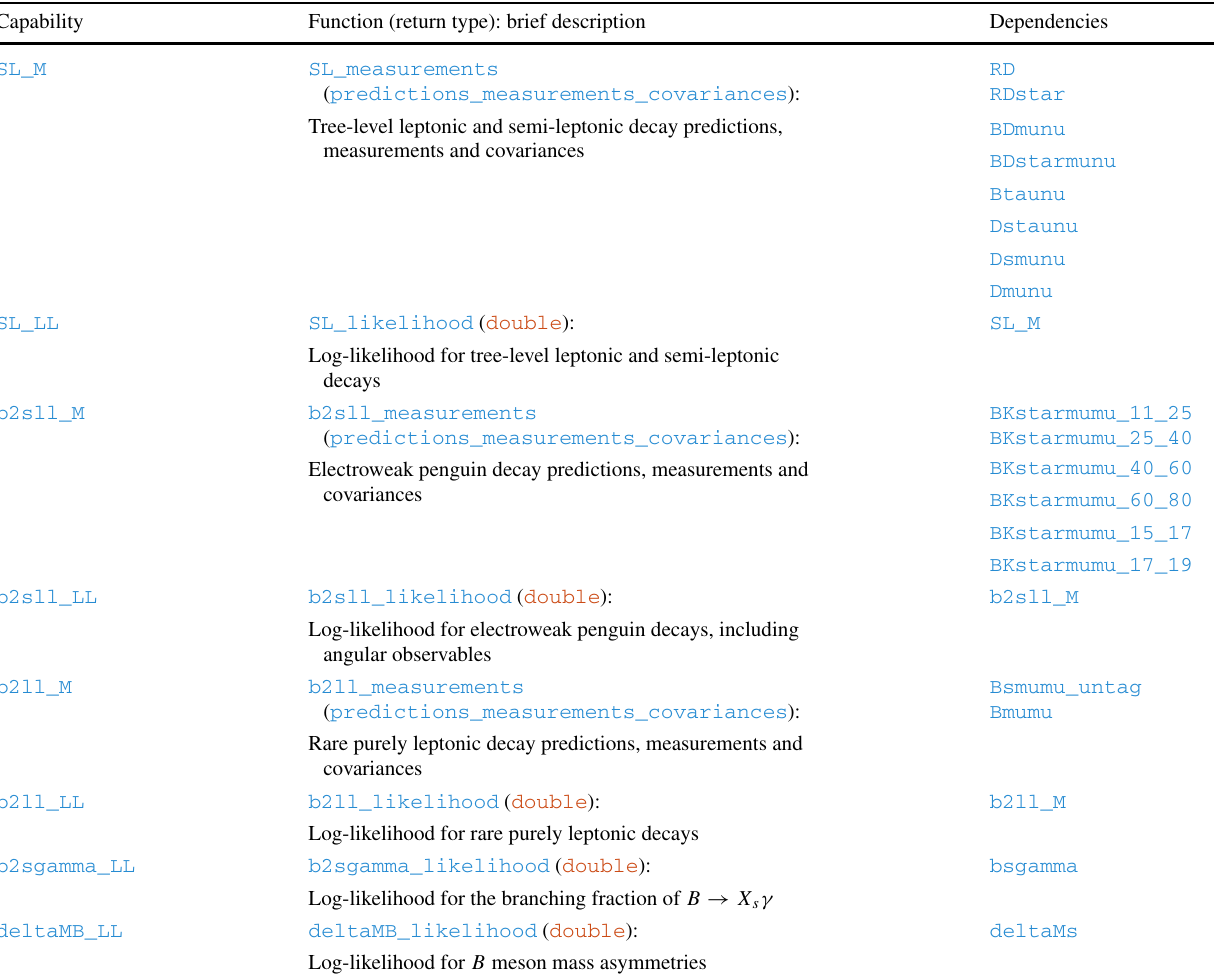
Table 8 Likelihood capabilities of FlavBit . All measurement functions (capabilities ending in _M ) return experimental and theoretical central values, as well as experimental and theoretical covariance